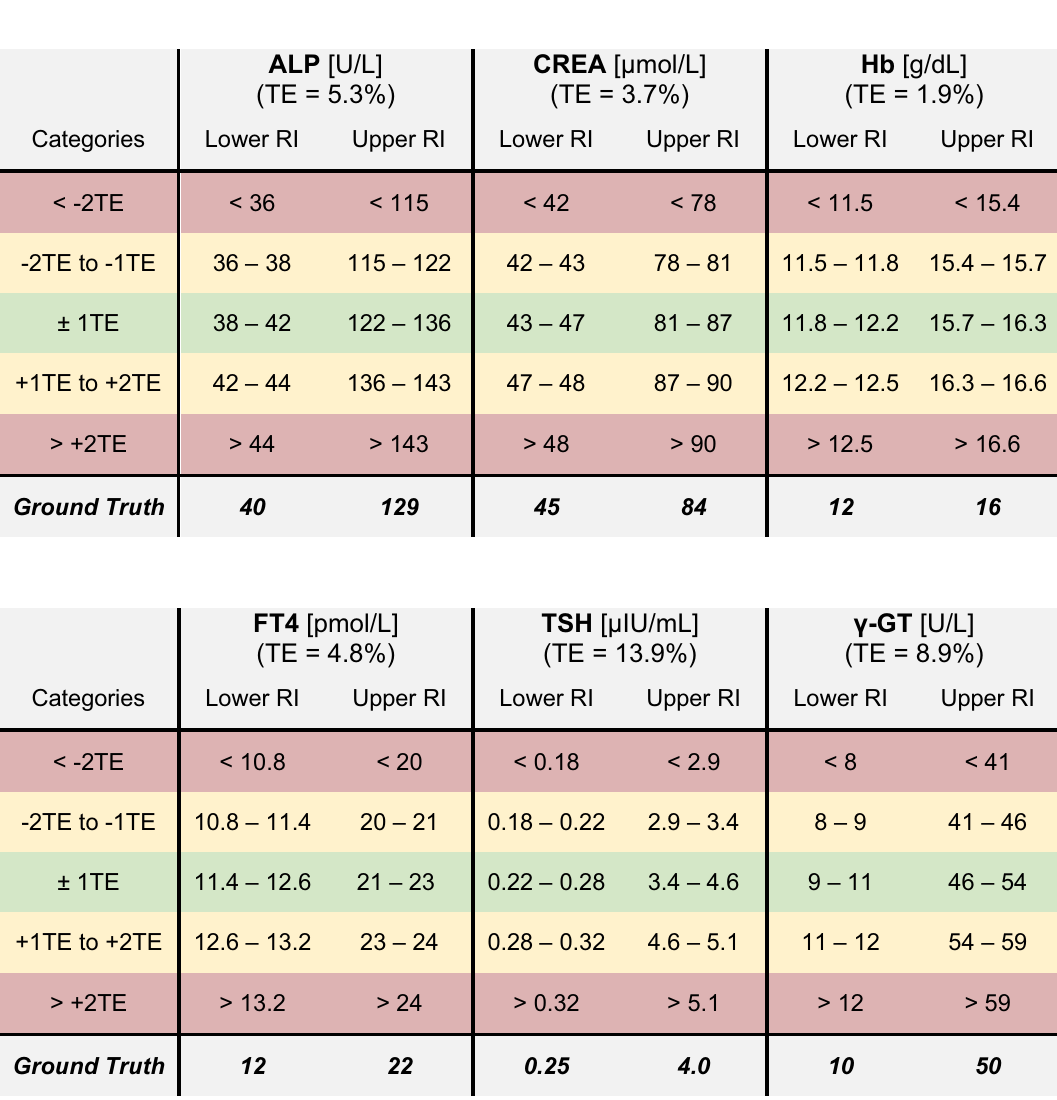
Table 1. Definition of evaluation categories for different simulated analytes using the total error specification. The table shows for each simulated biomarker the ranges of the absolute deviation from the ground truth used for defining the color-coded evaluation categories. TE total error, RI reference interval. Legend (adapted from Zierk et al. 22 ): Green (Within ± 1TE)—Appropriate for RI estimation. Yellow (Within ± 2TE)—Appropriate for quality control. Red (Outside ± 2TE)—Inappropriate estimations. Use with caution in select